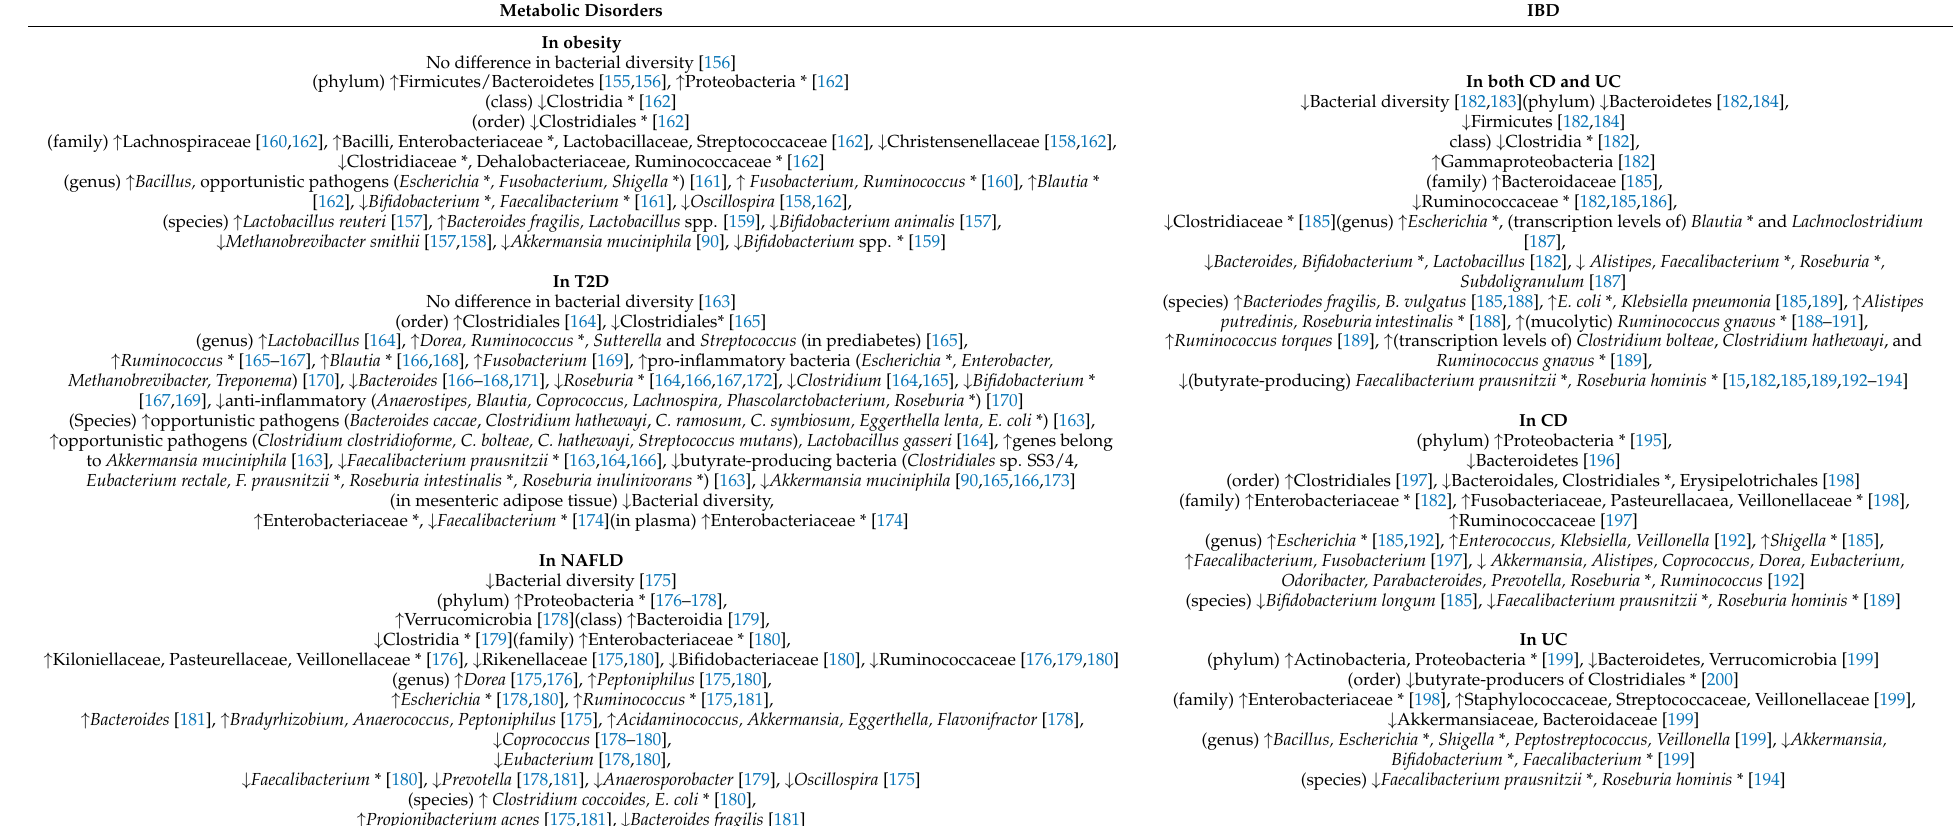
Table 2. Alterations in gut microbiota in metabolic disorders and